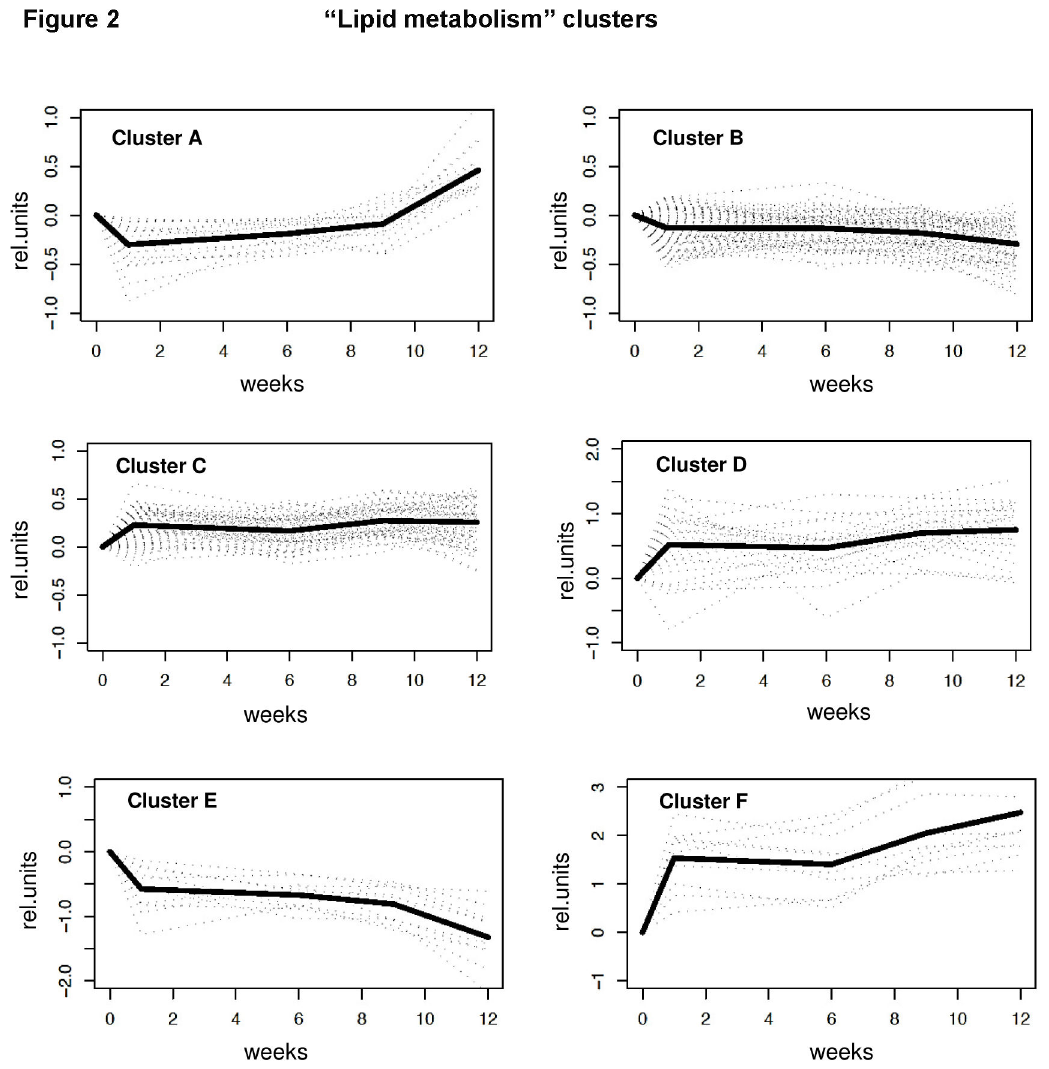
Figure 2. Cluster analysis of genes of lipid metabolism. Bayesian cluster analysis of genes with ‘lipid metabolism’ gene ontology resulted in 6 clusters (A, B, C, D, E, and F) with distinct time profiles. Individual gene expression profiles are shown as dotted lines. The bold line represents the cluster